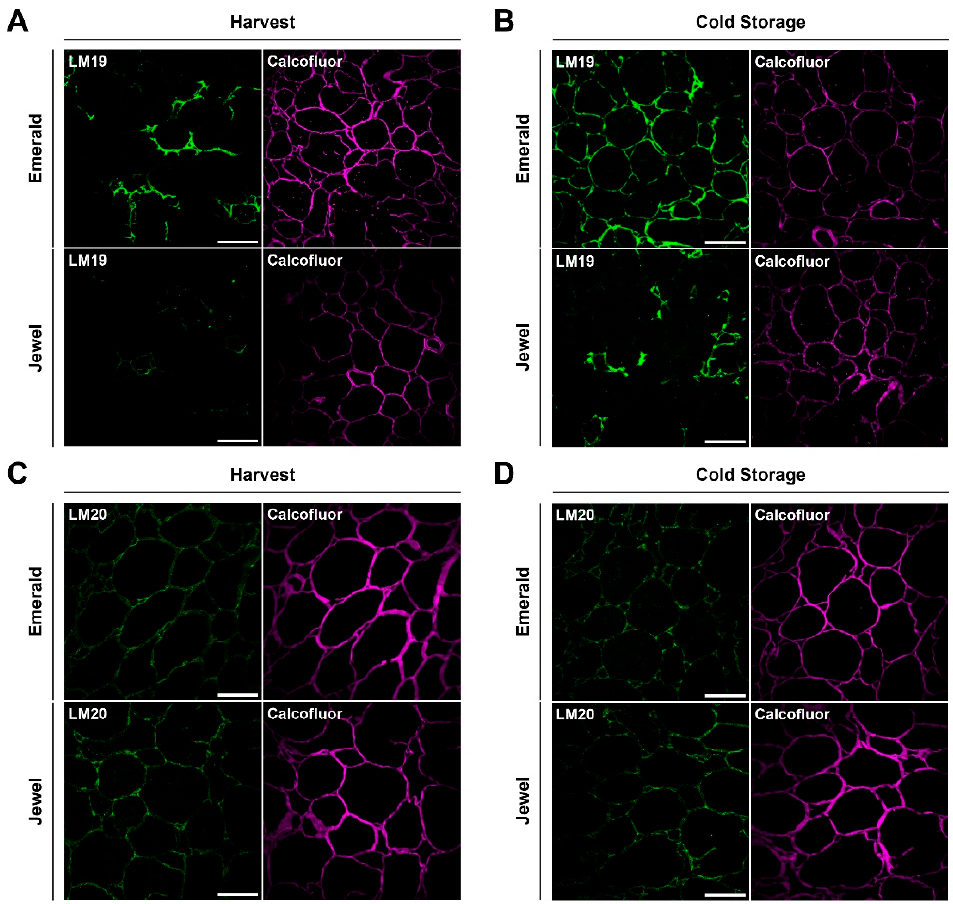
Figure 4. Immunolabeling of blueberry tissues from “Emerald” and “Jewel” cultivars at harvest and after 30 d of cold storage. Demethylesterified homogalacturonan detection (green) at harvest ( A ) and cold storage ( B ). Highly methylesterified homogalacturonan detection (green) at harvest ( C ) and after 30 d of cold storage ( D ). Counterstaining of cellulose (magenta). Bars = 100 µm (n = 3).